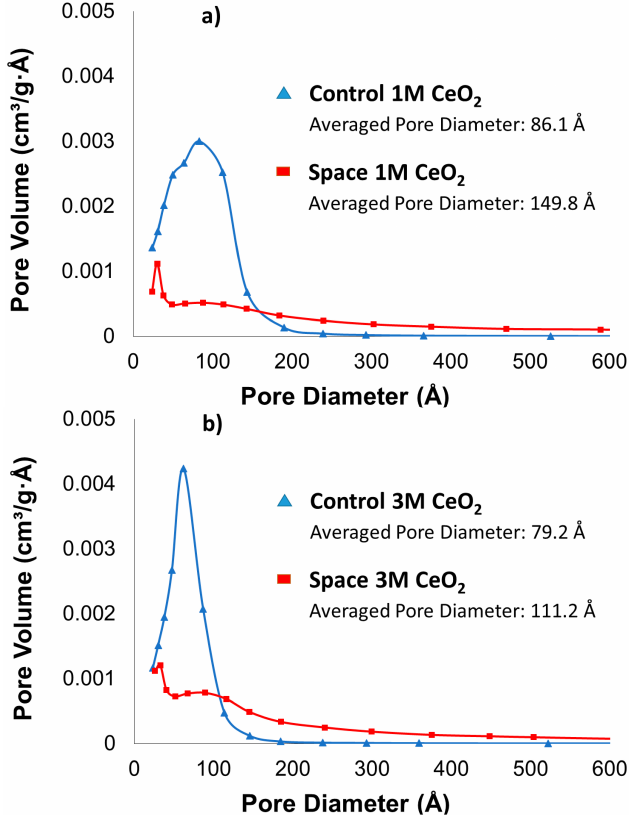
Figure 1. Barrett-Joyner-Halenda (BJH) Pore size distribution of CeO 2 sample measured using N 2 physisorptionprepared ( a ) with 1M NaOH ( b ) with 3M